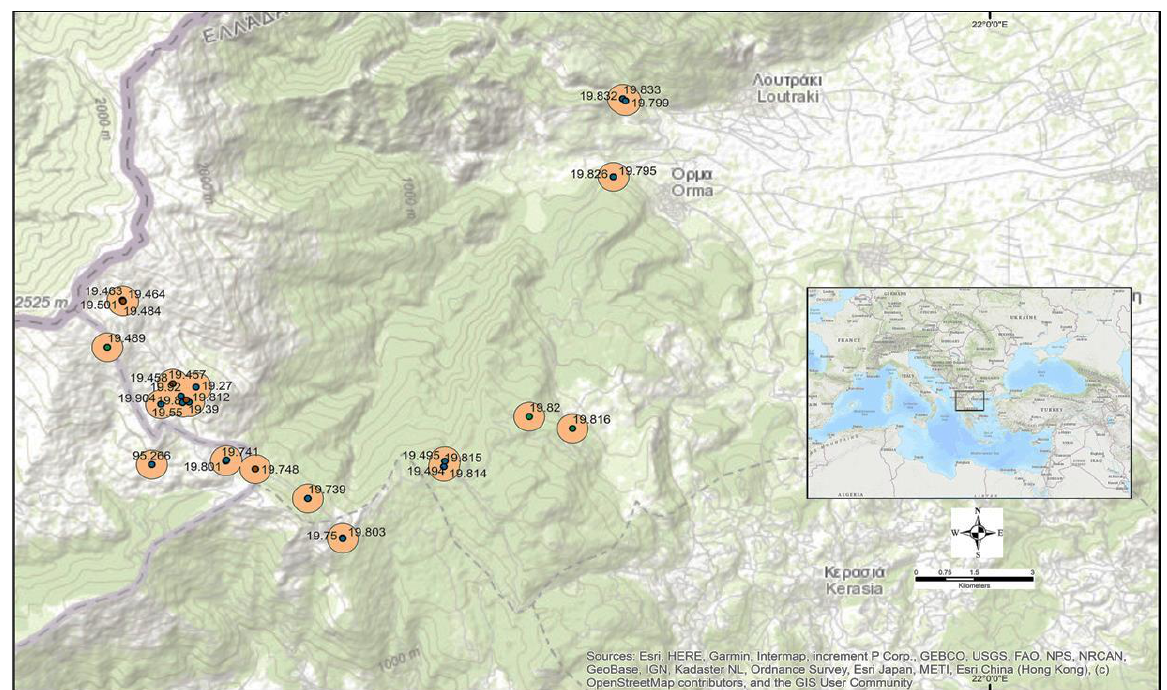
Figure 2. Overview of the botanical collections performed on Mt Voras (altitude 2521 m above sea level) in NW Greece indicating the area examined (around 300 m around every collection locality) for actual risks-threats that each taxon faces in its wild habitat. PCA: Threatened and Near Threatened plants (red central dots), PCB: Local Balkan endemics and subendemic plants (green central dots), PCC: Rare and/or uncommon plants (yellow central dots). The numbers correspond to abbreviated accession numbers documenting each collection. For individual accession numbers, see Supplementary material Table S1.